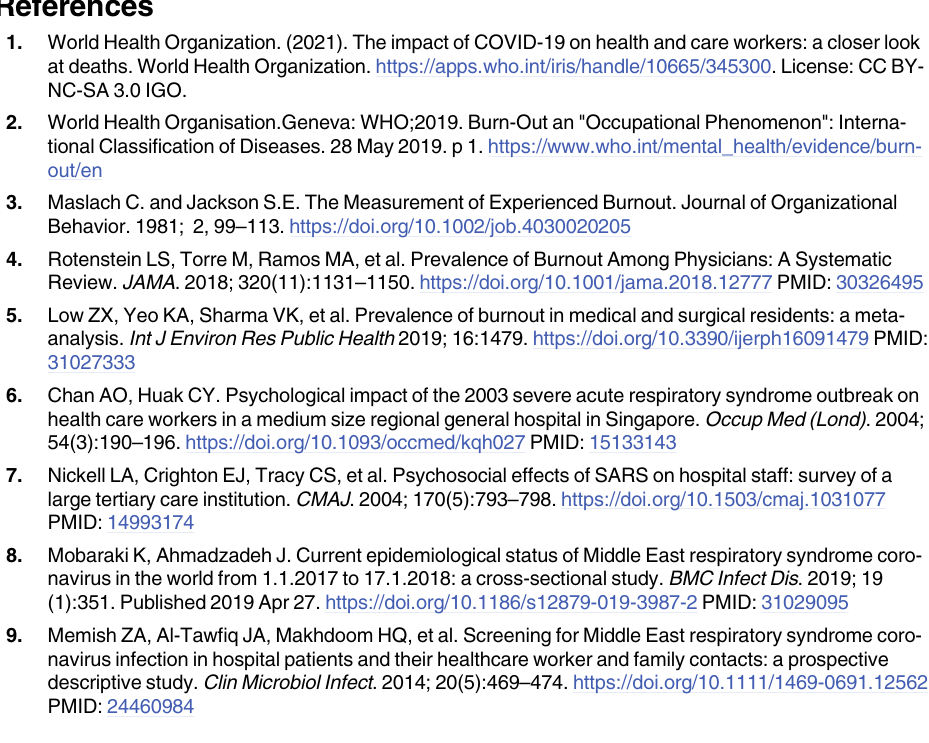
S1 Table. Post-hoc